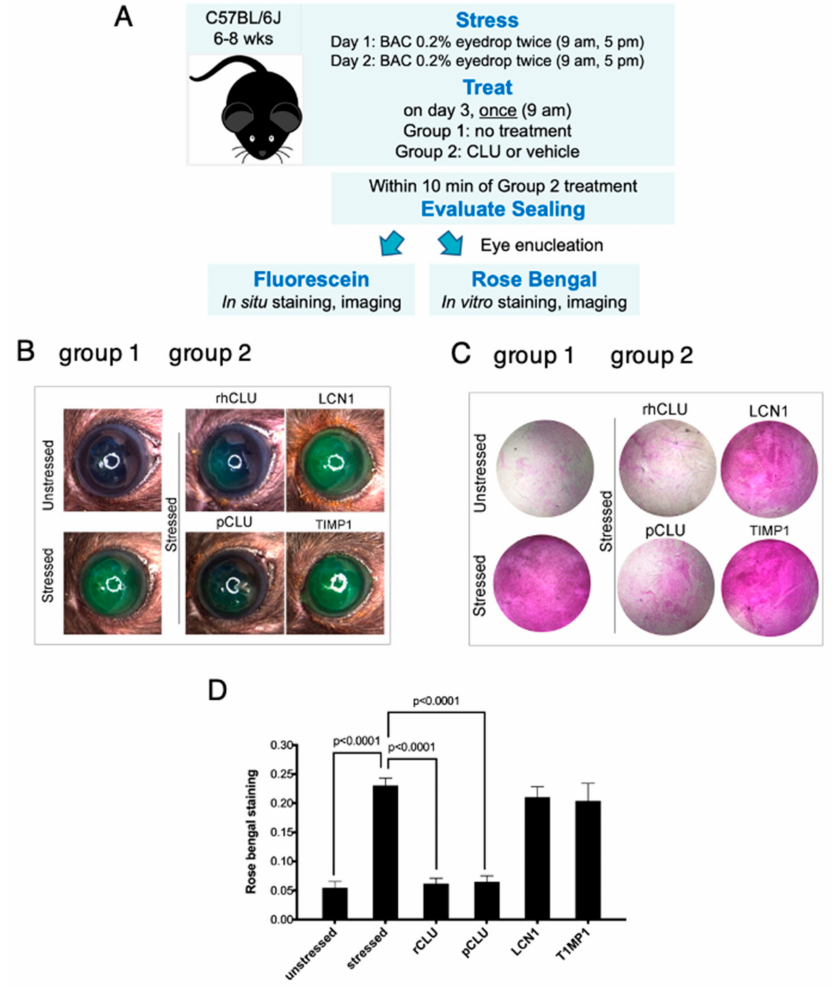
Figure 5. Efficacy and selectivity of GMP-compatible rhCLU in sealing the ocular surface barrier damaged by BAC. ( A ) A single drop of a BAC solution (0.2% dissolved in PBS) was applied to the ocular surface twice (9 a.m., 5 p.m.) on day 1, and twice (9 a.m., 5 p.m.) on day 2. In one group of mice, right eyes were subjected to the 2-day BAC protocol, while left eyes were left unstressed. In a second group of mice, both right and left eyes were subjected to the 2-day BAC stress protocol. One the morning of day 3, right eyes of the second group were treated topically with rhCLU- α C-H2ST (rhCLU) formulated in PBS at 100 µ g/mL or with one of the reference proteins, recombinant human LCN1 or recombinant human TIMP1, also formulated in PBS at 100 µ g/mL; left eyes were treated with PBS vehicle alone. Within 10 min, sealing was assayed in eyes of both groups by staining with fluorescein ( B ) or rose bengal ( C ). Shown are representative examples from each subgroup. ( D ) Quantified values for rose bengal staining, expressed as the mean ± SD ( n = 3). Statistical significance was determined by ANOVA and significant p -values are